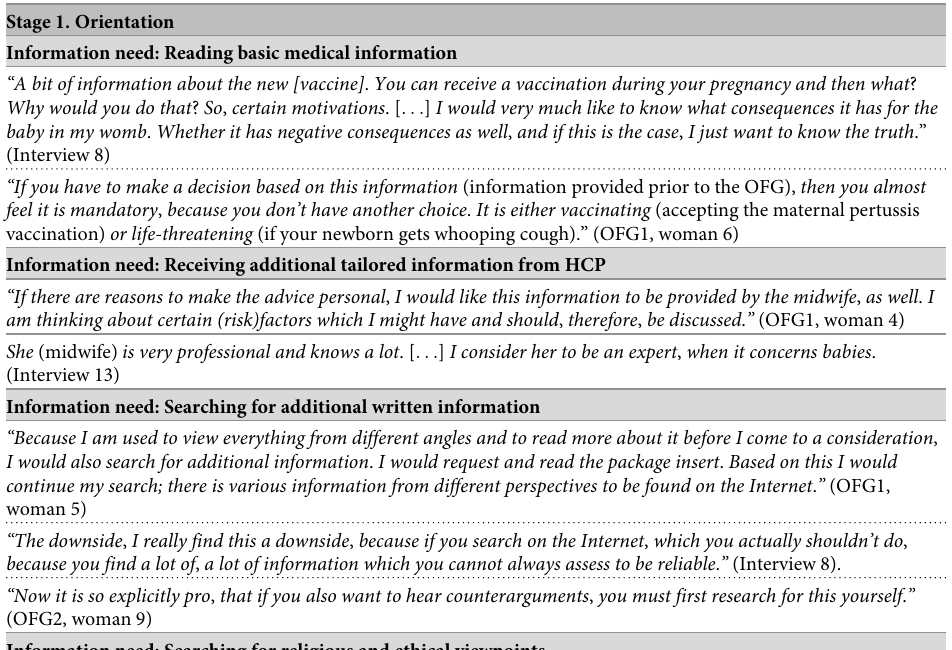
Table 4. Quotes from orthodox Protestant women during interviews and online focus